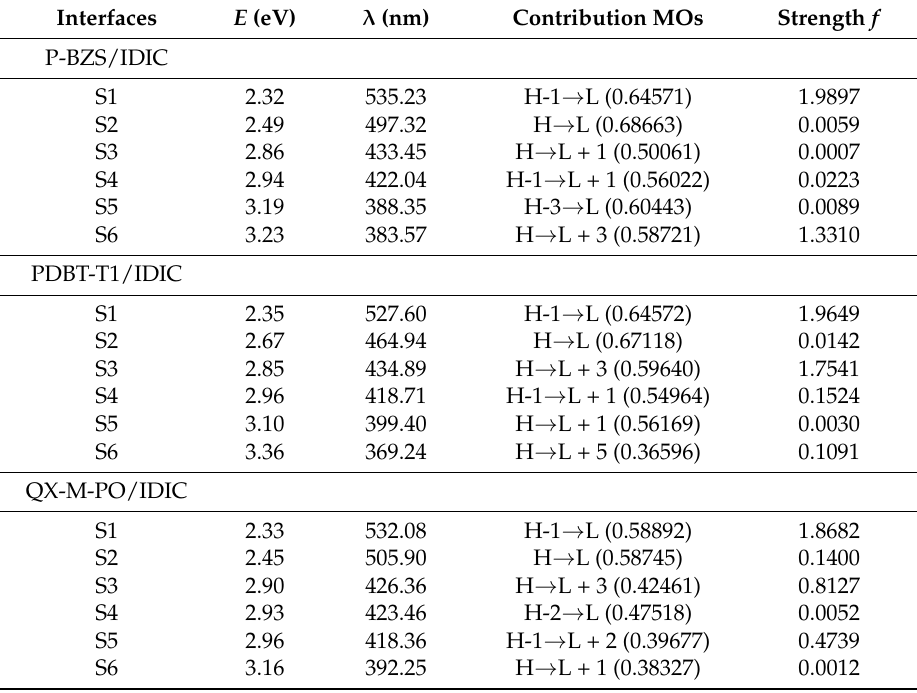
Table 10. Transition energies and oscillator strengths for D/A interfaces polymer/IDIC. Interfaces Contribution MOs Strength